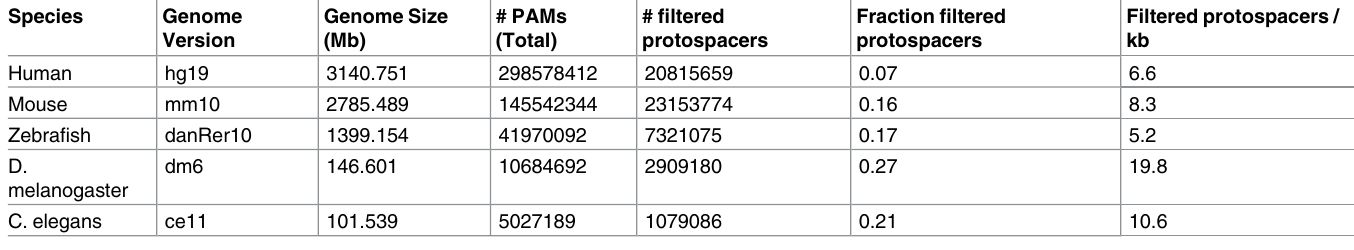
blue bars in Fig 2B, Table 2 and Supplementary S8 File). Together, off-target and efficiency score filters eliminate 96% of candidate protospacers in human (Fig 2B), but nevertheless yielding an average density of 6.6 usable protospacers per kilobase (Fig 2A). Comparison across species shows that there is markedly lower density of usable filtered protospacer sequences in vertebrates compared to invertebrates (Fig 2A). In general, and even after applying off-targets and score fil- ters, the minimum deletion size constrained by sequence features alone is less than 150 bp for the majority of genomic regions (Supplementary S7 File). In the final step, optimal sgRNA pairs are selected. First, all possible pairs of filtered proto- spacers are enumerated and ranked. Two ranking approaches are available: by combined effi- ciency score (default), or by length of deleted region. Ranking by score will tend to result in pairs that are more evenly distributed throughout the targeting region, but with a heteroge- neous distribution of deletion sizes. Conversely, ranking by length favours shorter intervals within the constraints of the targeting design. Short segments may be more efficiently deleted [20], but will tend to be clustered into a smaller genomic region. Table 2. Species analysed by CRISPETa and for which off-target databases were compiled. Filtered protospacers are those passingdefault off-target and efficiency score cutoffs.